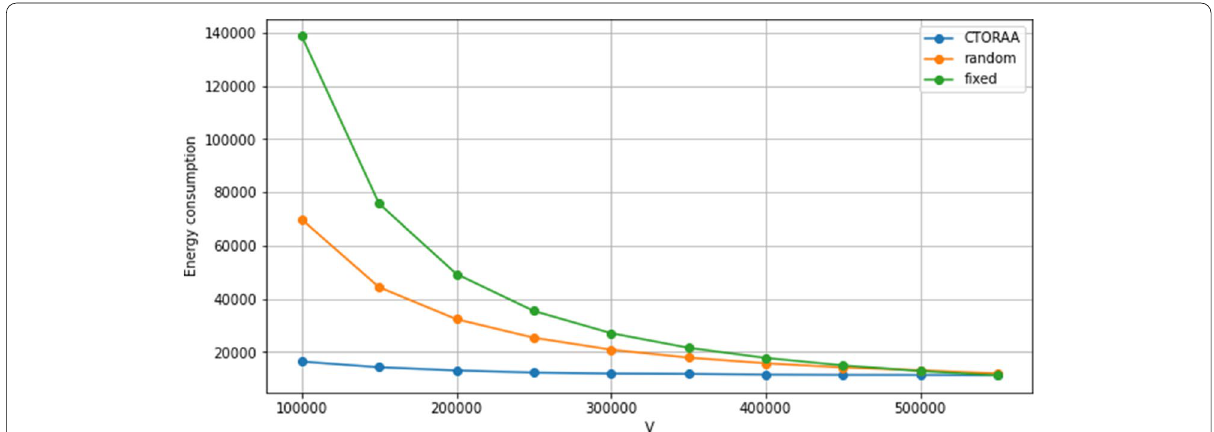
Fig. 6 Energy consumption with different